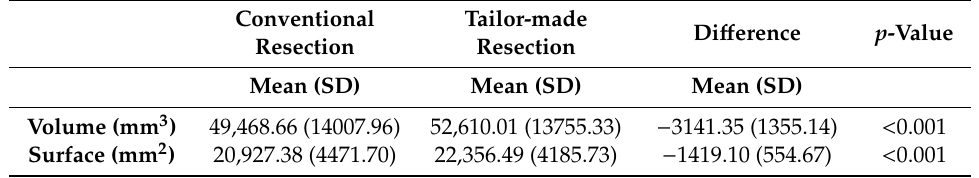
Table 3. Comparison of the volumes and surfaces between conventional resection simulation and tailor-made resection